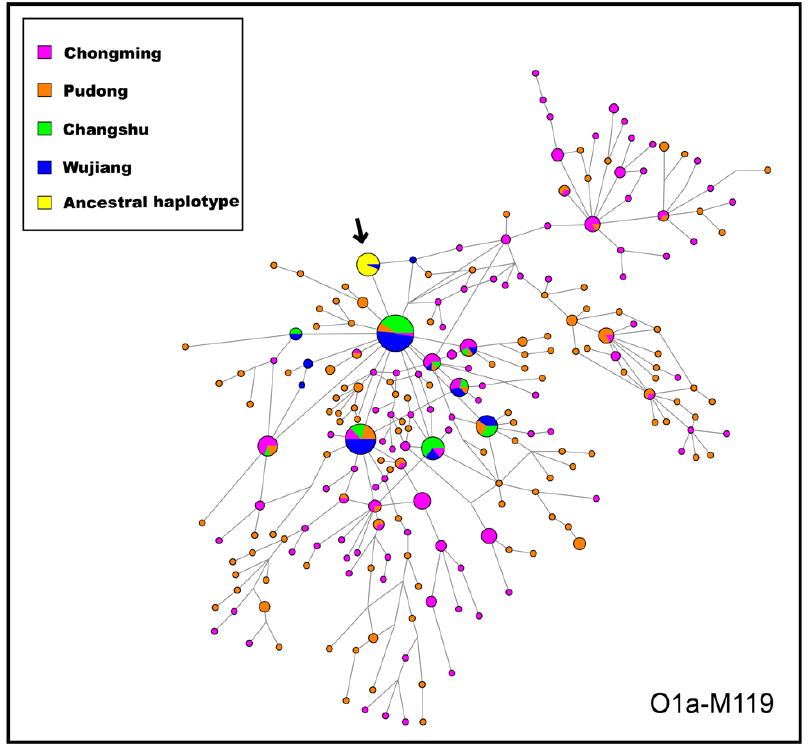
Figure 7. Median-joining network of Y chromosomal short tandem repeat (Y-STR) haplotypes of four populations of haplogroup O1a-M119.